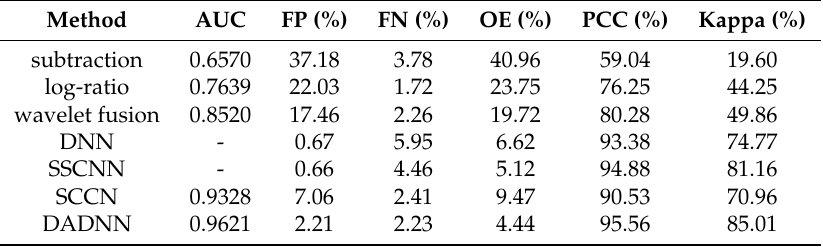
Table 4. Value of evaluation criteria of the Yellow River data set.